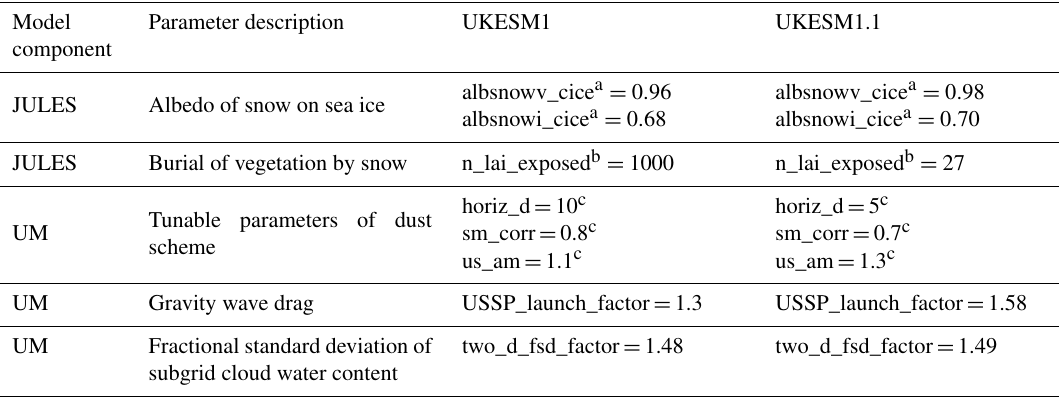
Table 2. Summary of tuned parameters in UKESM1 and UKESM1.1.